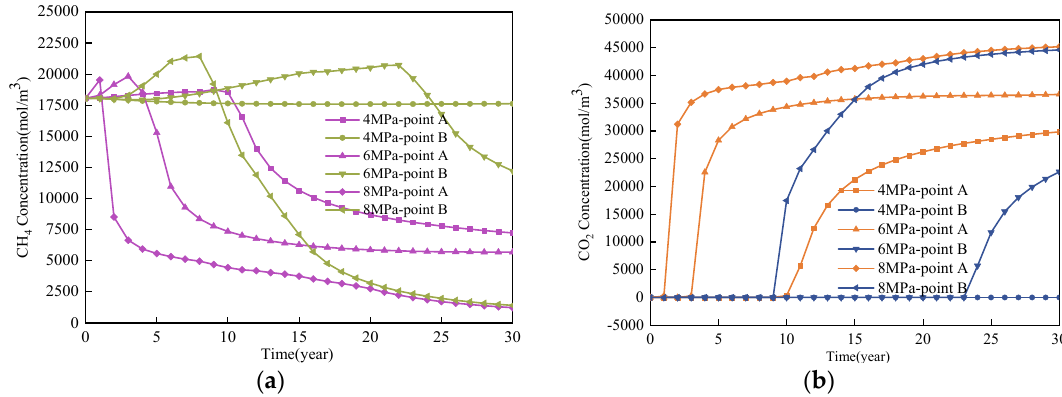
Figure 6. CH 4 and CO 2 molar concentrations at monitoring points A and Bunder different CO 2 injection pressures: ( a ) CH 4 molar concentration and ( b ) CO 2 molar concentration.